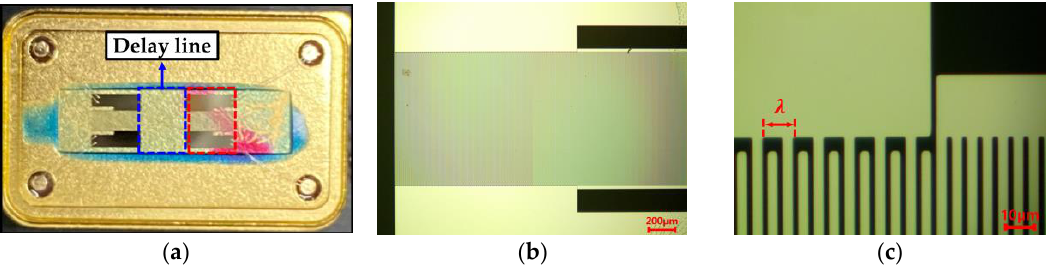
Figure 1. Optical microscope image of the IDT on a SAW sensor module: ( a ) SAW sensor module; ( b ) IDT pattern; ( c ) Design parameter of IDT.